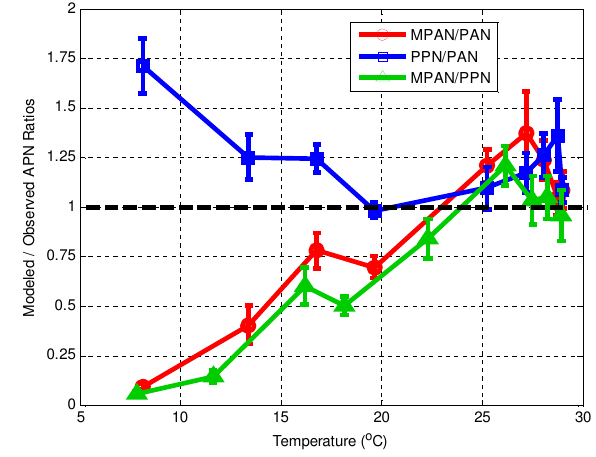
Fig. 6. Modeled-to-observed ratios for: PPN/PAN ratio (blue squares), MPAN/PAN ratio (red circles), and MPAN/PPN (green triangles). The bars represent the 1 σ variance of the